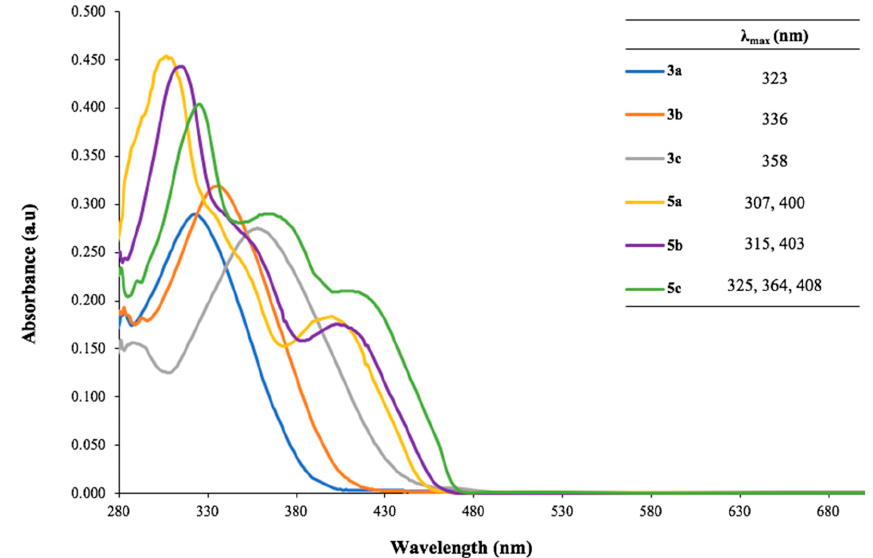
Figure 1. Ultraviolet (UV)-visible absorbance spectra (280–700 nm) of 10 μ M cinnamil derivatives ( 3a –